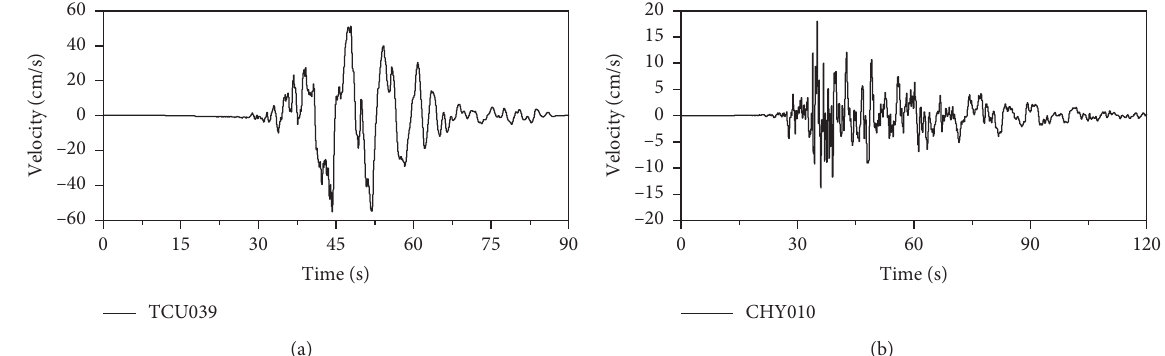
Figure 5: Velocity time-history curves of the near-fault earthquake records. (a) Forward-directivity near-fault earthquake. (b) Ordinary near-fault earthquake.